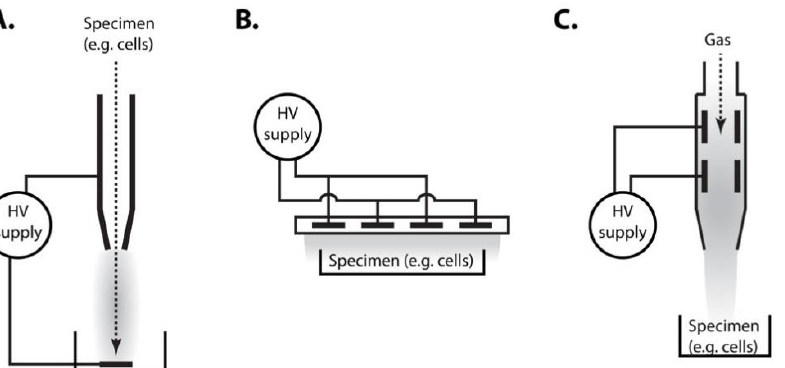
Figure 1. Typical experimental settings used for plasma treatment of cells. ( A ) Treated specimen is pumped through the hollow electrode and passes through electrical discharge, in which plasma (in all panels depicted in grey) is generated. ( B ) Plasma is generated by a discharge between elec- trodes separated by insulating dielectric barrier. Specimen is exposed to the plasma. ( C ) In plasma jet devices, plasma is generated between two electrodes inside a nozzle and streaming gas trans- mits plasma to the specimen. In all these settings, specimen may either contain treated cells (direct treatment) or certain type of medium (e.g., water), in which cells are subsequently incubated (indi- rect